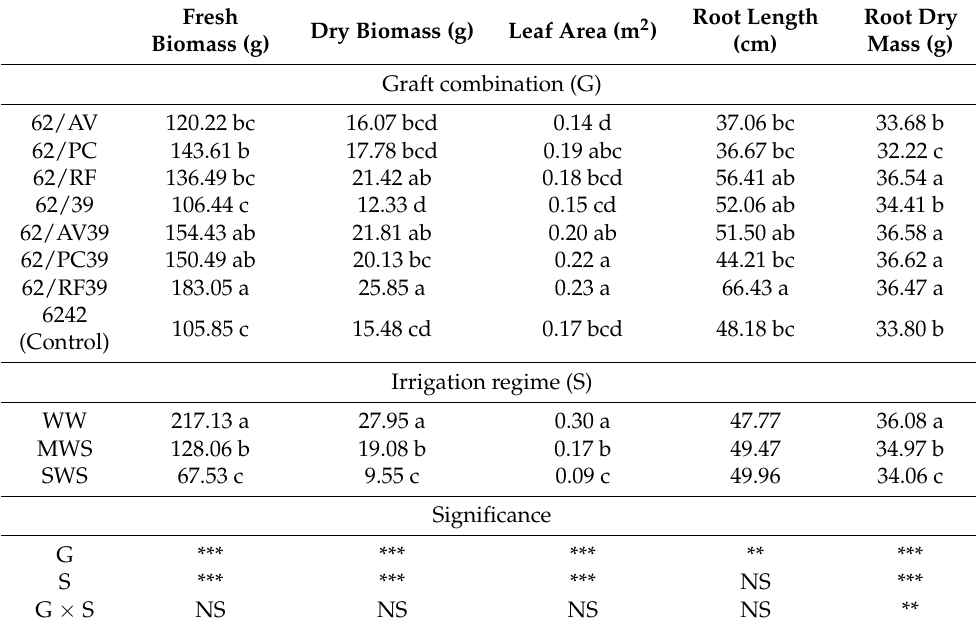
Table 3. Influence of grafting and water stress on shoot and root parameters (plant − 1